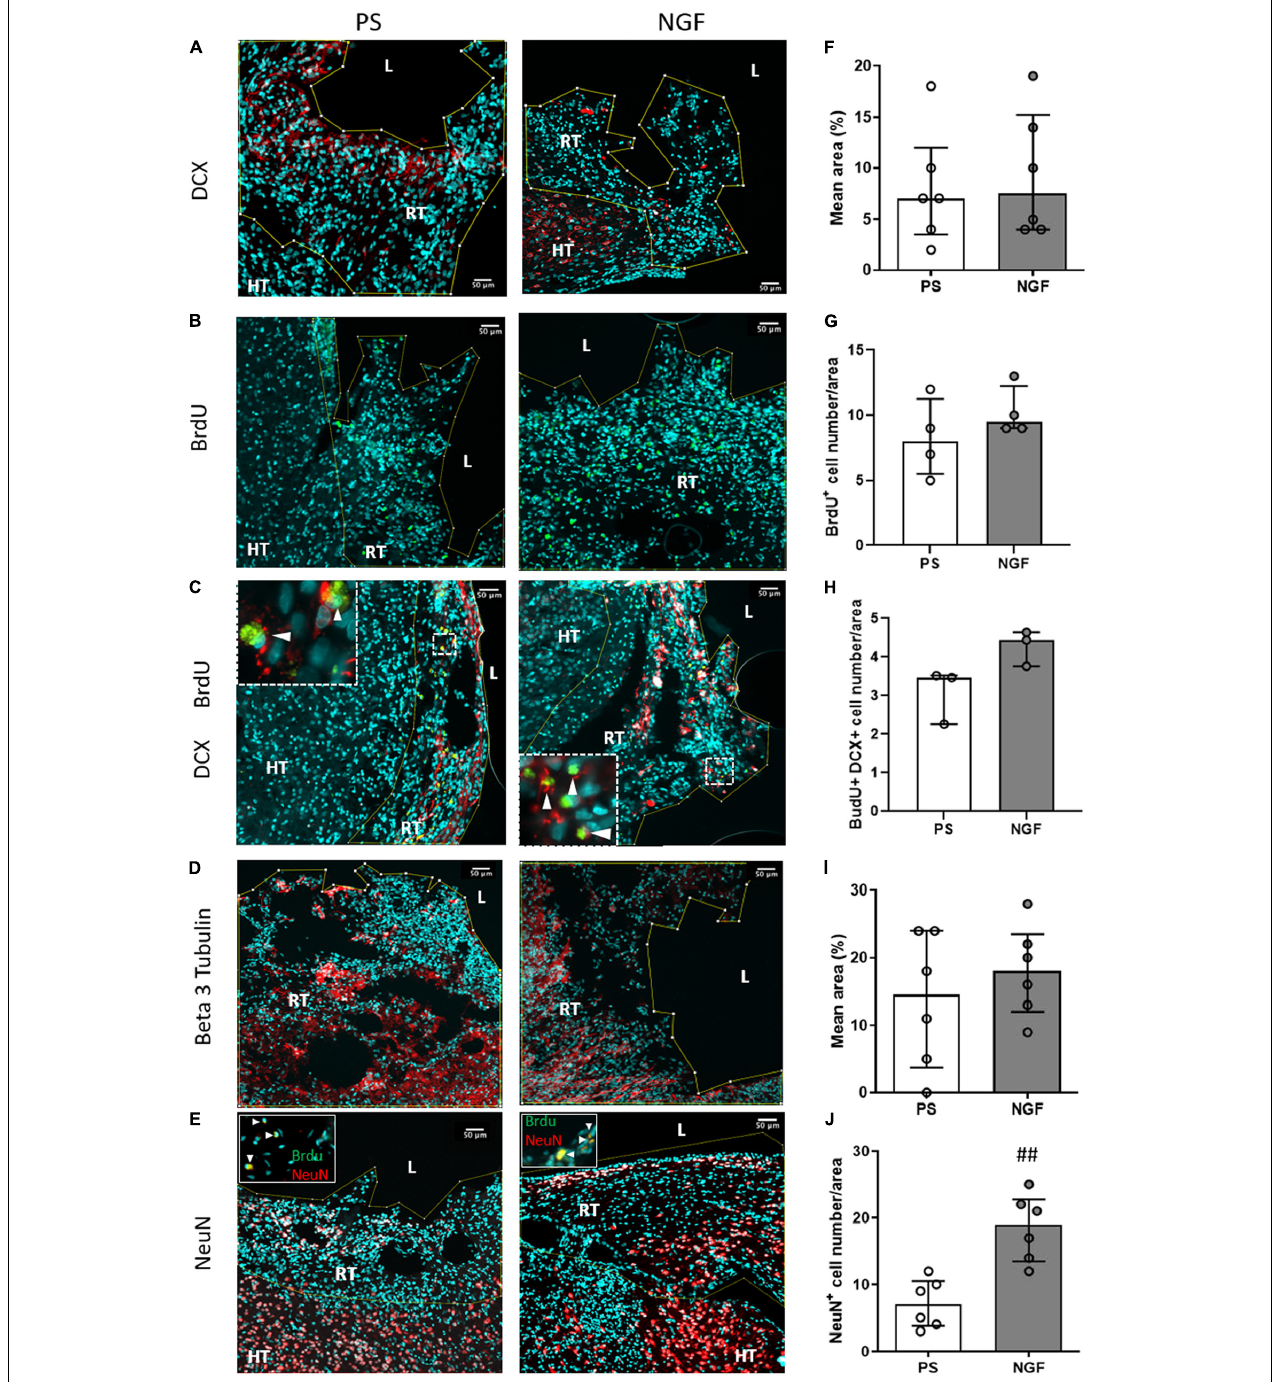
FIGURE 7 | Histology of brain sections and characterization of the reconstructed tissue neurogenesis. Representative images and quantification of DCX (A,F) , beta 3 tubulin (D,I) mean intensity, NeuN (E,J) cell number (percentage of DAPI+ cells) and BrdU (B,H) cell number (percentage of DAPI+ cells) in the reconstructed tissue in PS ( left ) and NGF ( middle ) groups. Double staining with BrdU/DCX and BrdU/NeuN is shown in panel (C,E) (inserts). (C) Representative image showing BrdU (green) and DCX (red) staining. The inserts show the cells expressing both markers (white arrowheads). (E) Representative image showing NeuN (red) staining. The inserts show nuclei positives for BrdU (green) and NeuN markers (white arrowheads). No significant difference was observed for DCX, beta 3 tubulin and BrdU between the groups, as reported in the graphs (F–I) . A significant difference in percentage of NeuN positive-cells was observed between the groups (## p = 0.0043). All the graphs show the distribution of individual values and the median and the interquartile range. PS group: n = 6; NGF group: n = 7 except for BrdU. Scale bars: 50 µ m. PS: physiological saline; NGF: nerve growth factor; DCX: doublecortin; NeuN: neuronal nuclei; BrdU: 5-bromo-2-deoxyuridine. L: lesion; RT: reconstructed tissue; HT: healthy